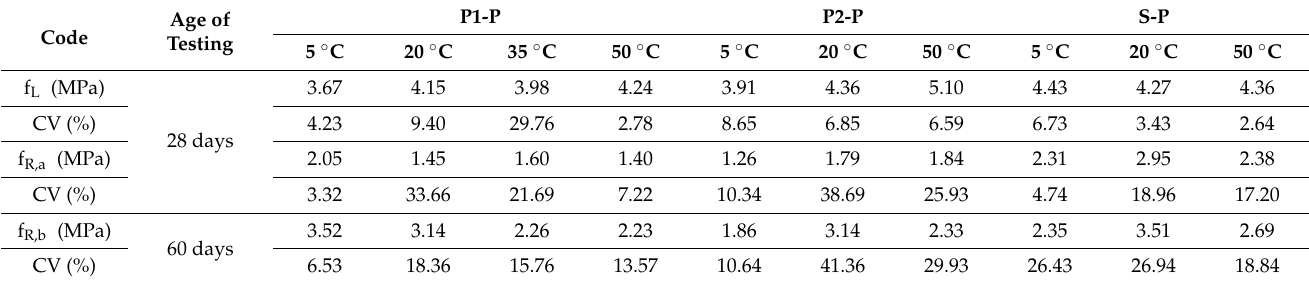
Table 7. Results of the residual flexural strengths obtained at moderate temperatures for pre-cracked specimens.